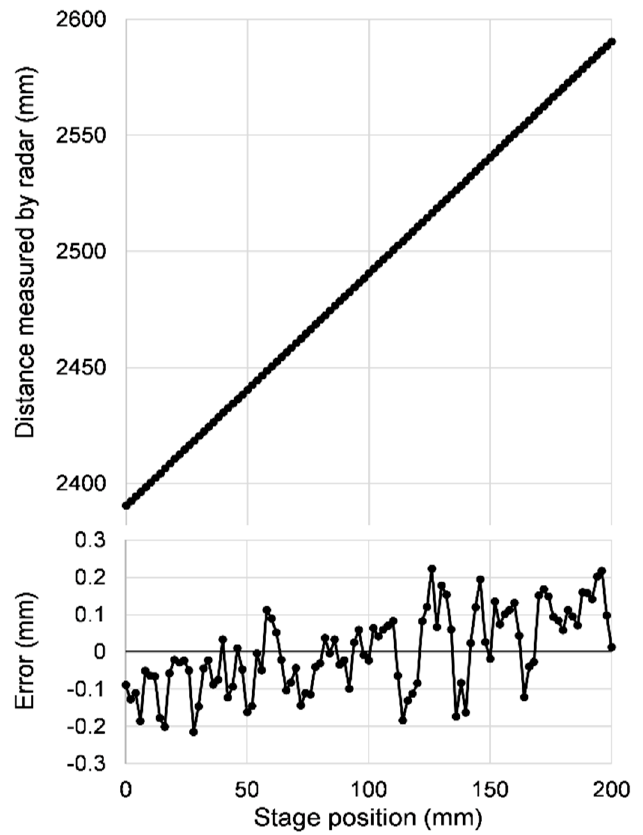
Figure 4. Distance measurement on one target at various positions of the motor stage, in 2 mm steps. The modulation frequency was scanned from 3 to 15 GHz in 512 steps. The top plot shows the absolute distance measured by the radar versus the stage position. As the measurement errors are too small to see at this scale, the bottom plot is added to show just the error, defined as the difference between the measured distance at each point and a linear fit through all points, with the slope fixed to 1. The standard deviation of the errors is 0.107